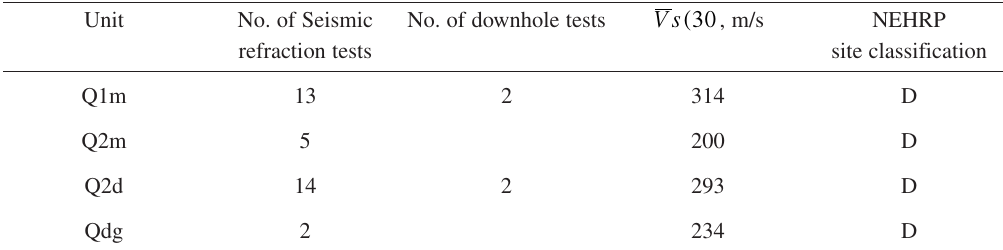
Table II. Seismic profiles and site classification in Rasht city.